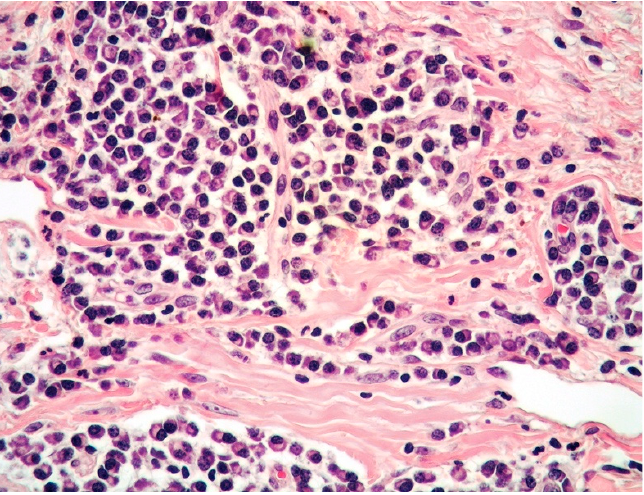
Figure 2. High-power view of PCMZL, plasmacytic variant, predominantly composed of mature plasma cells (HE, magnification 200×; original image from Prof. S.A.). The plasma cells expressed plasma cell-related markers, such as CD138, and were monotypic for kappa immunoglobulin light chain (Figures 3 and 4).